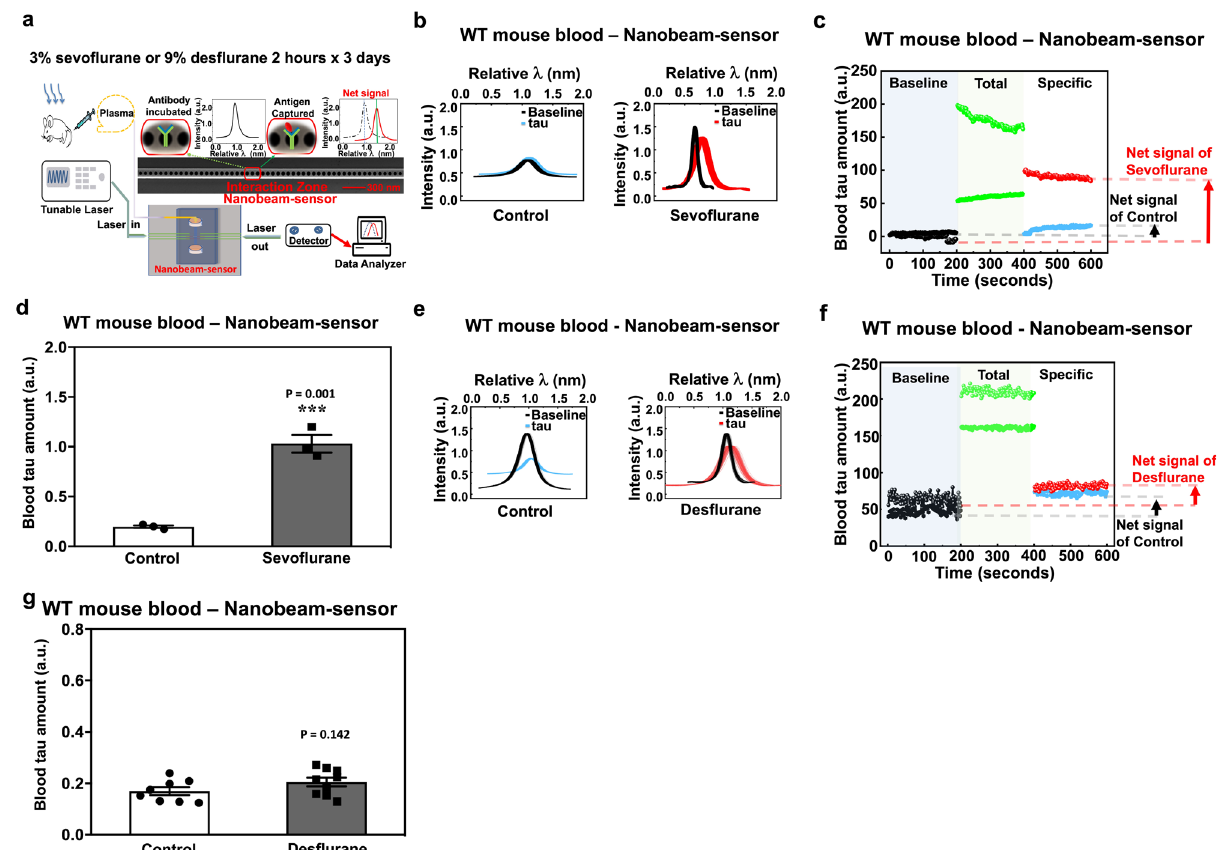
Fig. 1 Sevo fl urane increased amounts of tau in mouse blood. a Diagram of the experimental design. b Nanobeam-sensor spectrum data representing tau in the mouse blood following the control condition or sevo fl urane. c Nanobeam-sensor real-time data representing tau in mouse blood following the control condition or sevo fl urane. d Quanti fi cation of nanobeam-sensor determination of tau in the blood. Nanobeam-sensor spectrum data ( e ), real-time data ( f ), and quanti fi cation ( g ) representing tau in the mouse blood following the control condition or des fl urane. N = 3 or 9 mice (mouse blood study) in each group as demonstrated in each panel of the fi gure. Student ’ s t test was used to analyze the data presented in Figs. 1d, g. *** P < 0.001. The P values refer to the difference of tau amounts in blood between sevo fl urane or des fl urane and control condition. Error bar indicates standard deviation. WT